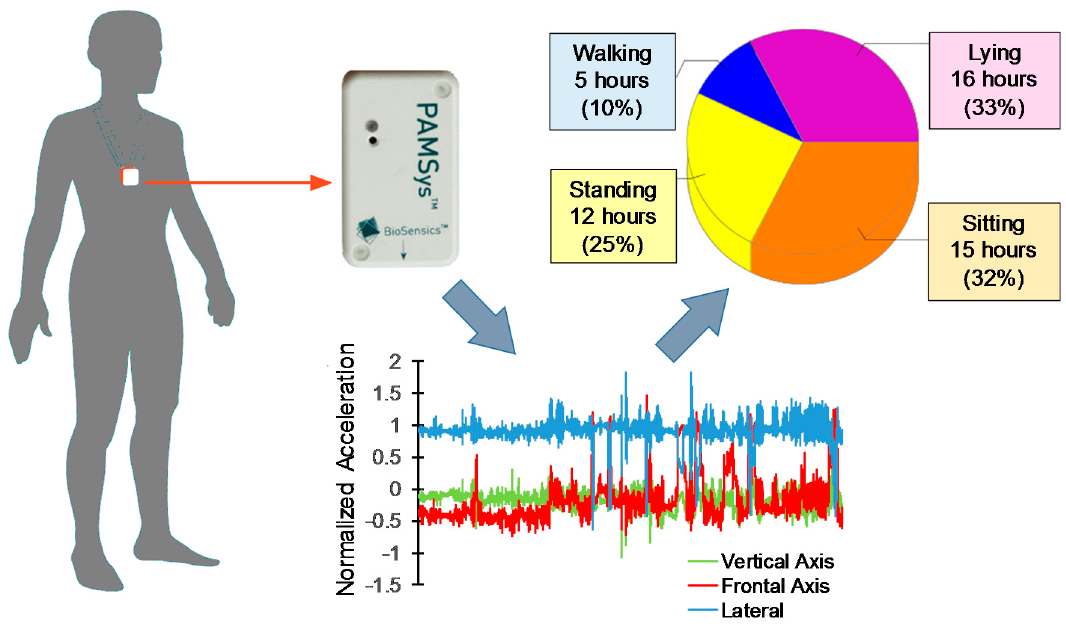
Figure 1. Triaxial accelerometer wearable sensor (PAMSys) was used to estimate the amount of physical activity and the number of steps. Results are presented for 48 h daily physical activity from one participant for baseline (pre-injection).